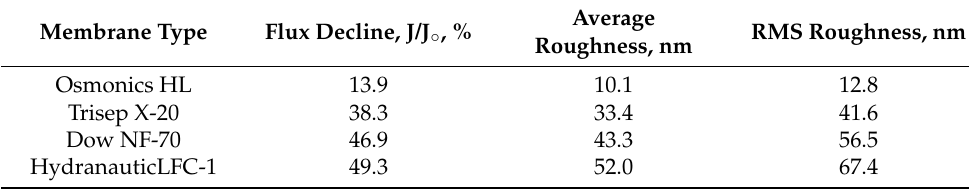
Table 1. Correlation between the surface roughness of commercial RO/NF membranes and their relative fluxes for the filtration of a 0.05 M NaCl solution containing 200 mg/L silica particles (0.10 µ m); pH = 6.8. Flux-decline values determined for 10 L of permeate volume filtered *. Membrane